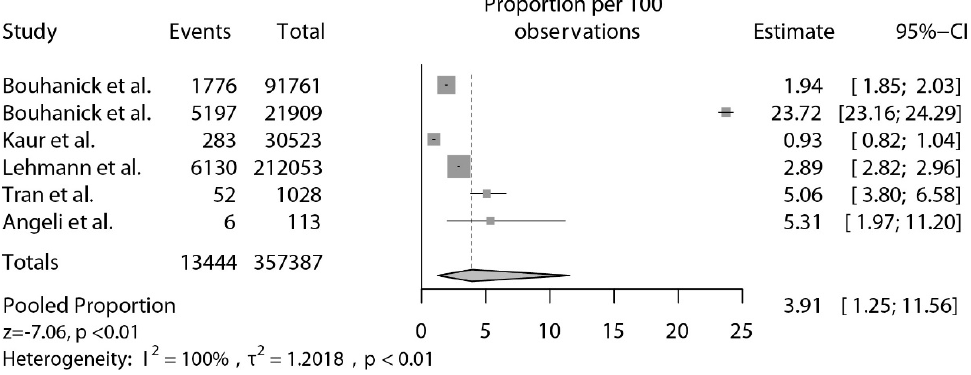
Figure 2. Proportions of increased BP after vaccination [25,35,36,38,40,41].